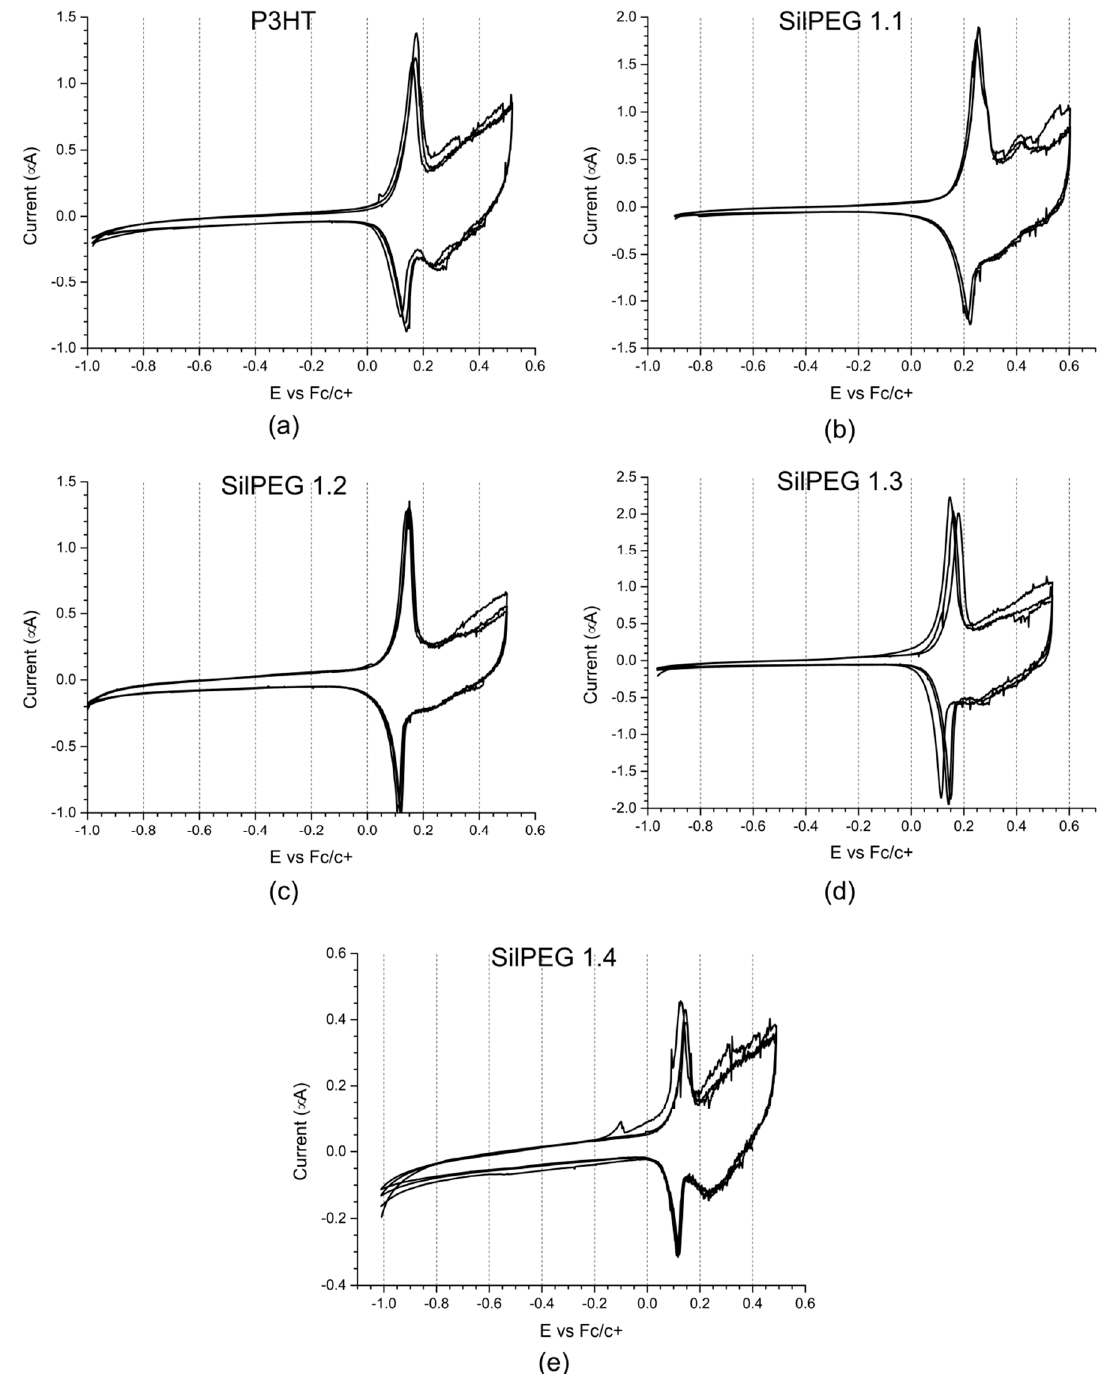
Figure A7. Electrochemical response of thin solid films of ( a ) regioregular P3HT; ( b ) SilPEG1.1; ( c ) SilPEG 1.2; ( d ) SilPEG 1.3; ( e ) SilPEG 1.4 deposited on a Pt wire electrode, in 0.1 M tetrabutylammonium tetrafluoroborate/acetonitrile. Potential scanning rate r = 0.005 V/s.